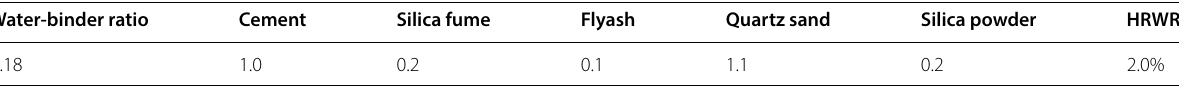
Table 1 Mixture proportion of UHPC by weight